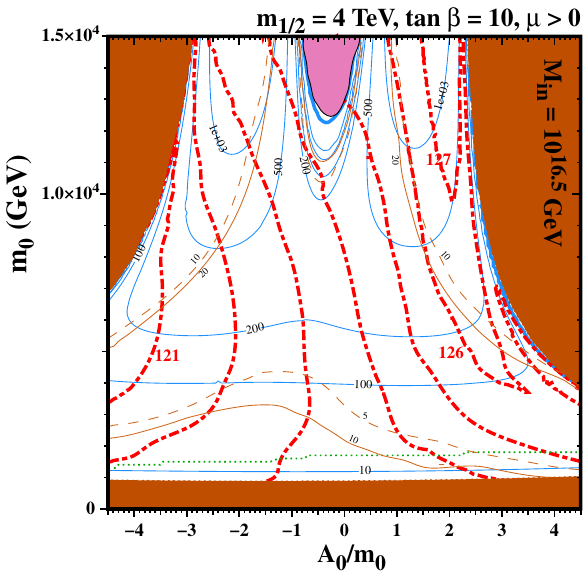
Fig. 2 A representative ( A 0 / m 0 , m 0 ) plane in the flipped SU(5) GUT model, with M in = 10 16 . 5 GeV, tan β = 10 , m 1 / 2 = 4 TeV, λ 4 = 0 . 3 ,λ 5 = 0 . 1 and λ 6 = 0 . 0001. Regions with a stau or stop LSP and without electroweak symmetry breaking are shaded brown and pink, respectively. The contour colours are as in Fig. 1, with contours for τ = 2 × 10 36 years and τ − σ τ = 10 36 years. The sole green dotted p p p line is a contour of (cid:12) a μ = 1 × 10 − 11